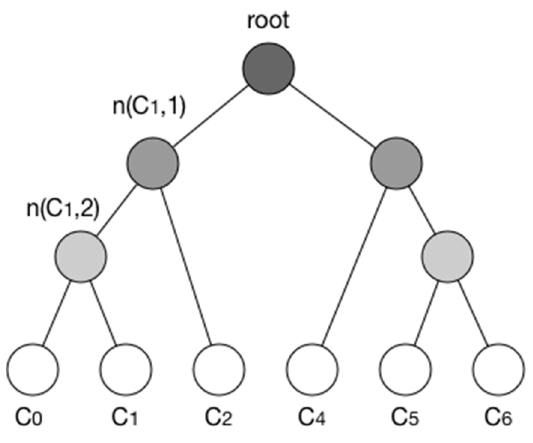
Figure 5. Hierarchical tree structure of the output layer.